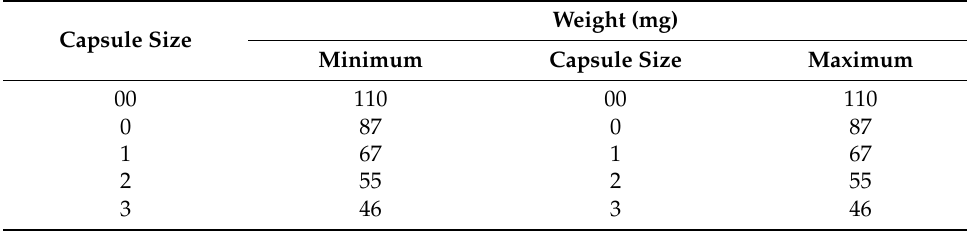
Table 1. Weight specification of hard gelatine capsules.